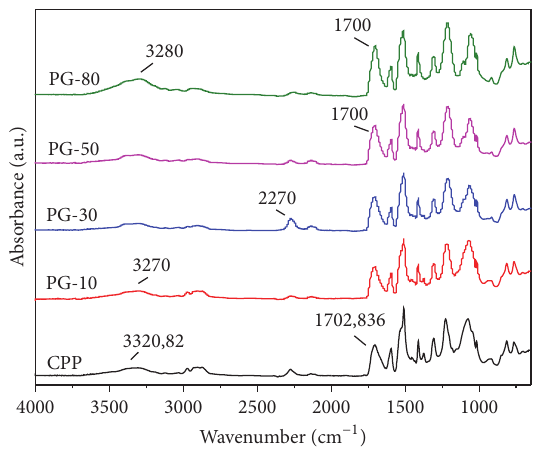
Figure 3: FTIR results of PUF samples with pure glycerol. results for all samples (crude glycerol, methanol-free crude glycerol, and pure glycerol) -NH vibrations are lower so there are no unreacted OH groups.